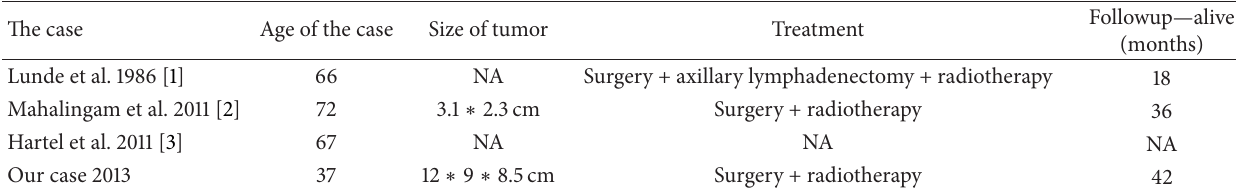
Table 1: Four patients’ characteristic.